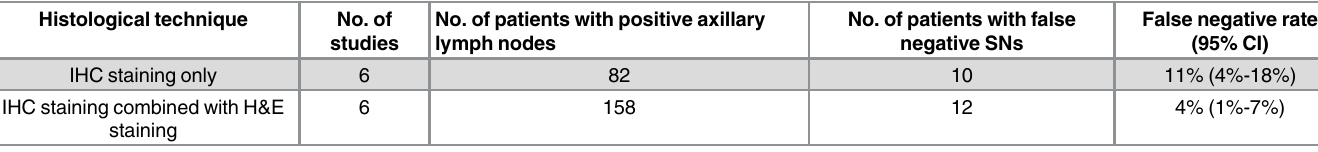
Table 4. False negative rate of SLNB according to histological technique. Histological